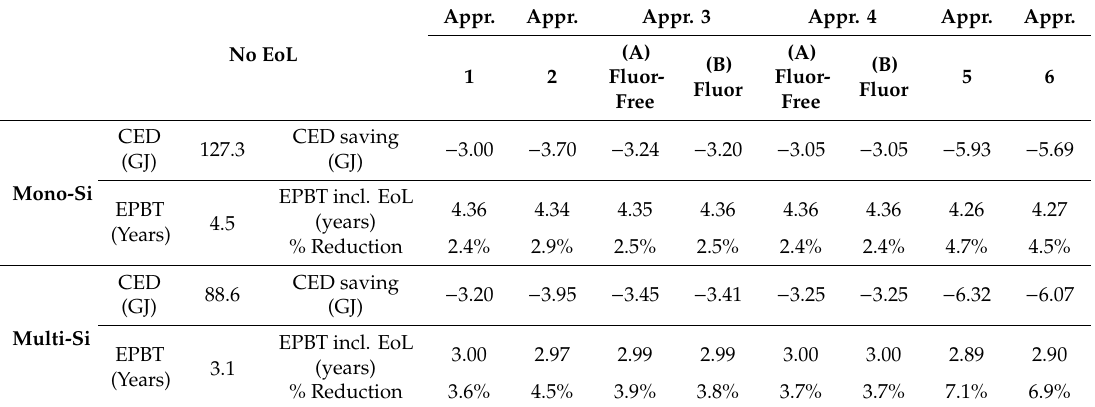
Table 4. Energy metrics with and without effects from EoL management.